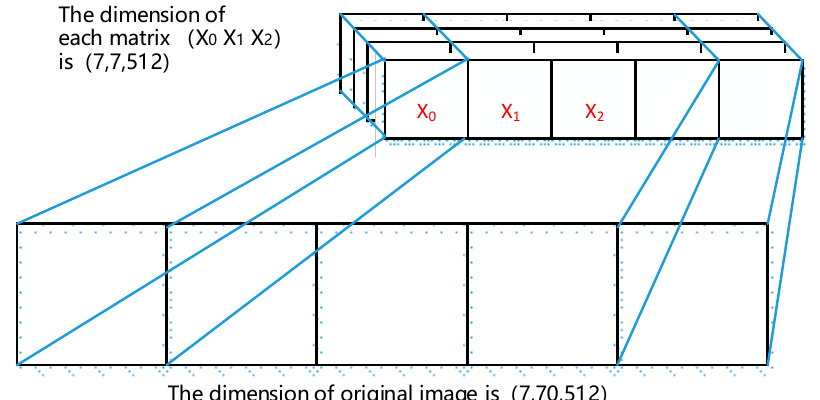
Figure 8. Correspondence between extracted features and the original image.